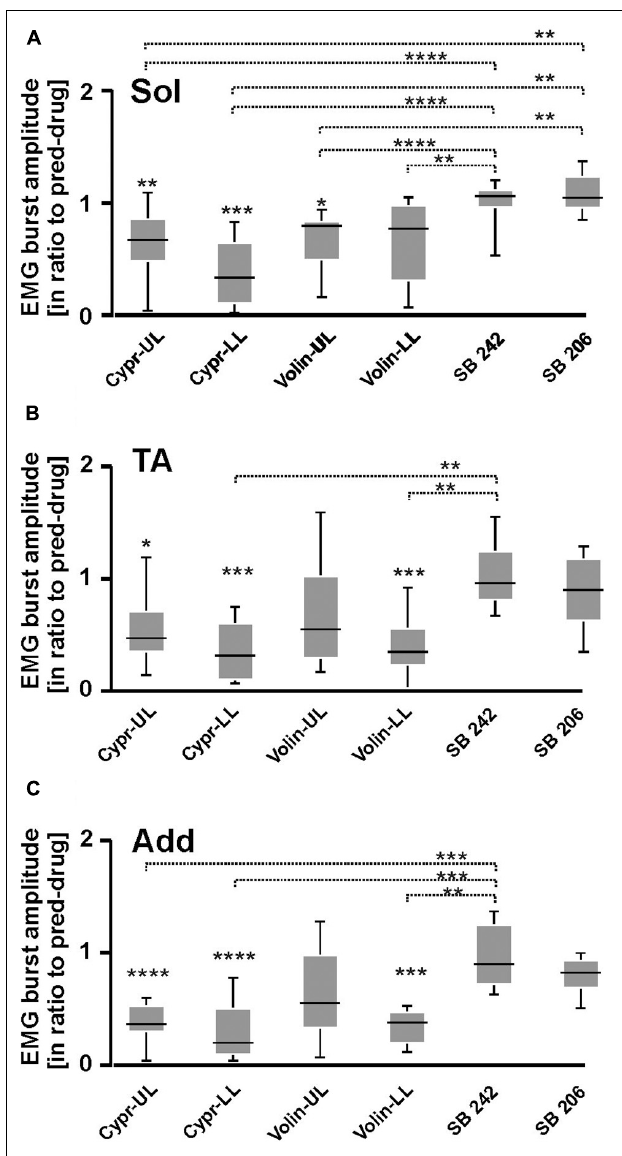
FIGURE 4 | EMG amplitude of soleus (A) , tibialis anterior (B), and adductor (C) muscles resulting from 5-HT receptor blockage by either Cyproheptadine, Volinanserin or SB 242084 or SB 206553 application in the lumbar spinal cord established for muscles of both rat hindlimbs. The significance of the results was tested using non-parametric Kruskal–Wallis test followed by Dunn’s multiple comparisons (* p < 0.05, ** p < 0.01, *** p < 0.001, **** p < 0.0001). Results from left and right muscles were pooled in all the rats in the various experimental conditions, so the number of samples taken for analysis were: Cypr_UL n = 12, Cypr_LL n = 10, Volin_UL n = 10, Volin LL n = 10, SB 242 n = 12, SB 206 n = 10. Add, adductor muscle; Sol, soleus muscle; TA, tibialis anterior muscle; Cypr, Cyproheptadine; Volin, Volinanserin; SB 242, SB 242084; SB 206, SB 206553; UL, upper lumbar segments (L2/L3); LL, low lumbar (L5/L6)